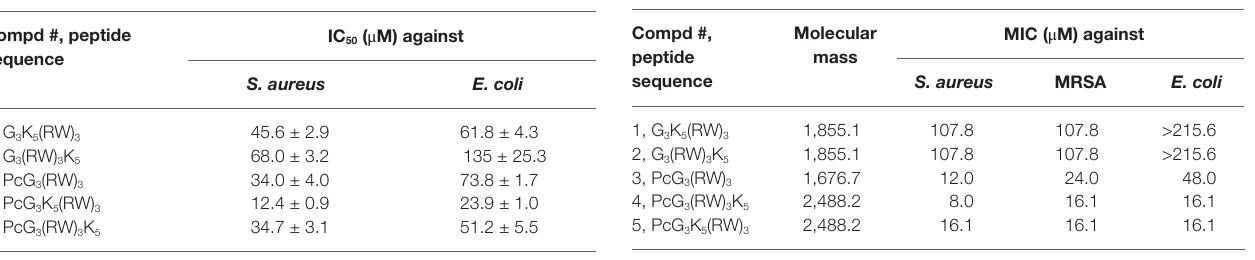
TABLE 2 | Minimum inhibitory concentrations (MICs) of antimicrobial peptides against different types of bacterial strains.